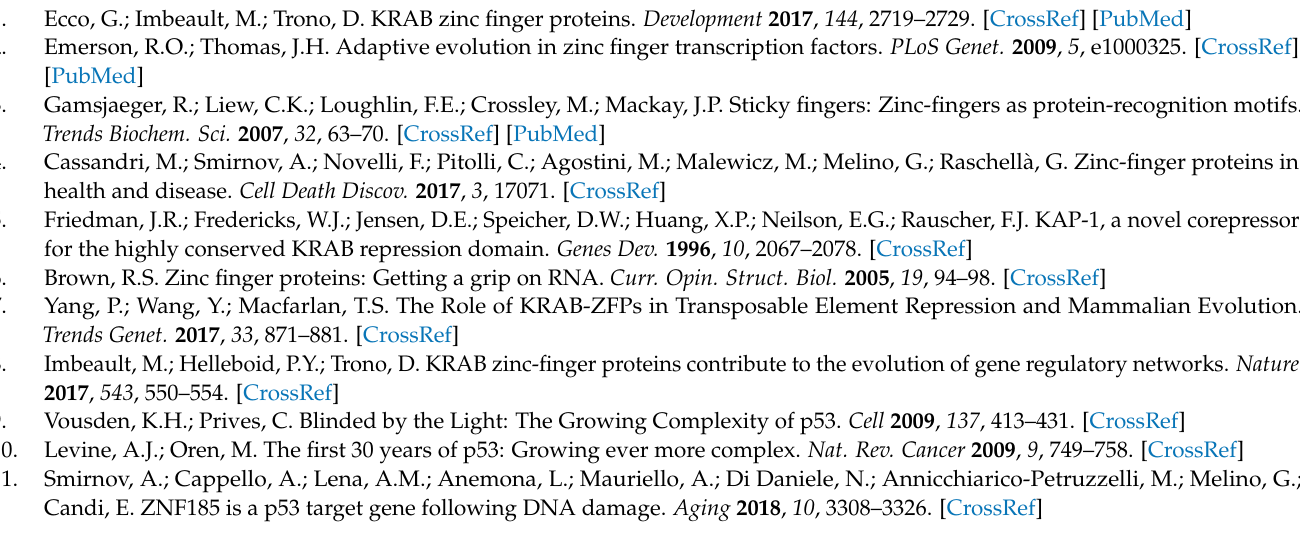
Figure S4: Strategy used to knock-out ZFP14 in cancer cell lines using CRISPR-Cas9; Table S1: siRNA oligonucleotides; Table S2: Primers used for qRT-PCR and RT-PCR; Table S3: Primers used for